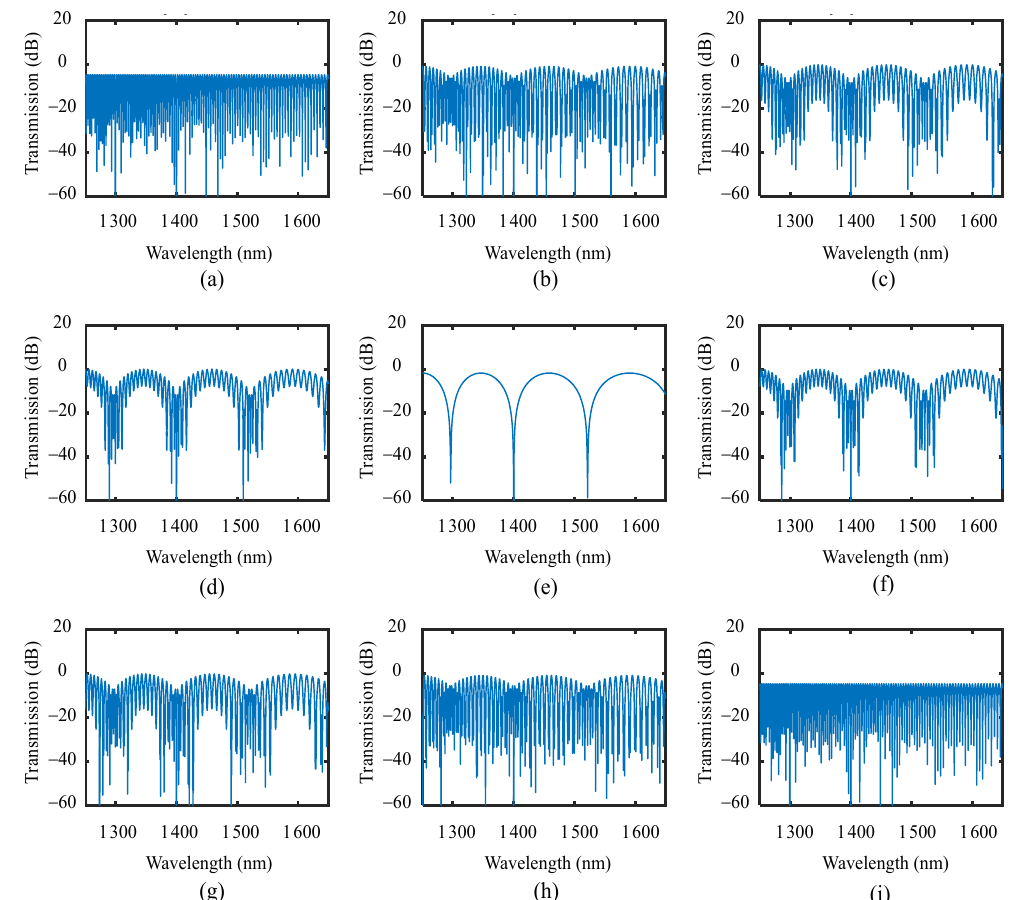
Fig. 2 Simulation results of transmission spectra changing with the intersection angle: (a)  =0  , (b)  =30  , (c)  =45  , (d)  =60  , (e)  =90  , (f)  =120  , (g)  =135  , (h)  =150  , and (i)  =180 